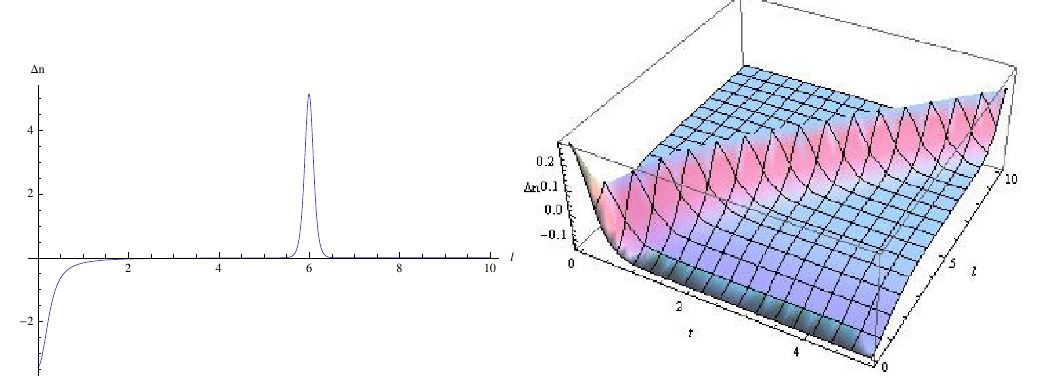
Figure 3 . The behavior of entanglement density (ED) under the global quenches. The left graph describes the ED (cid:1) n ( l; t ) as a function of l at t = 3 (we chose (cid:11) = 0 : 1). The right 3D plot shows the behavior of ED (cid:1) n ( l; t ) as a function of the time t (horizontal axis) and the subsystem size l (depth axis), where we set (cid:11) = 0 :